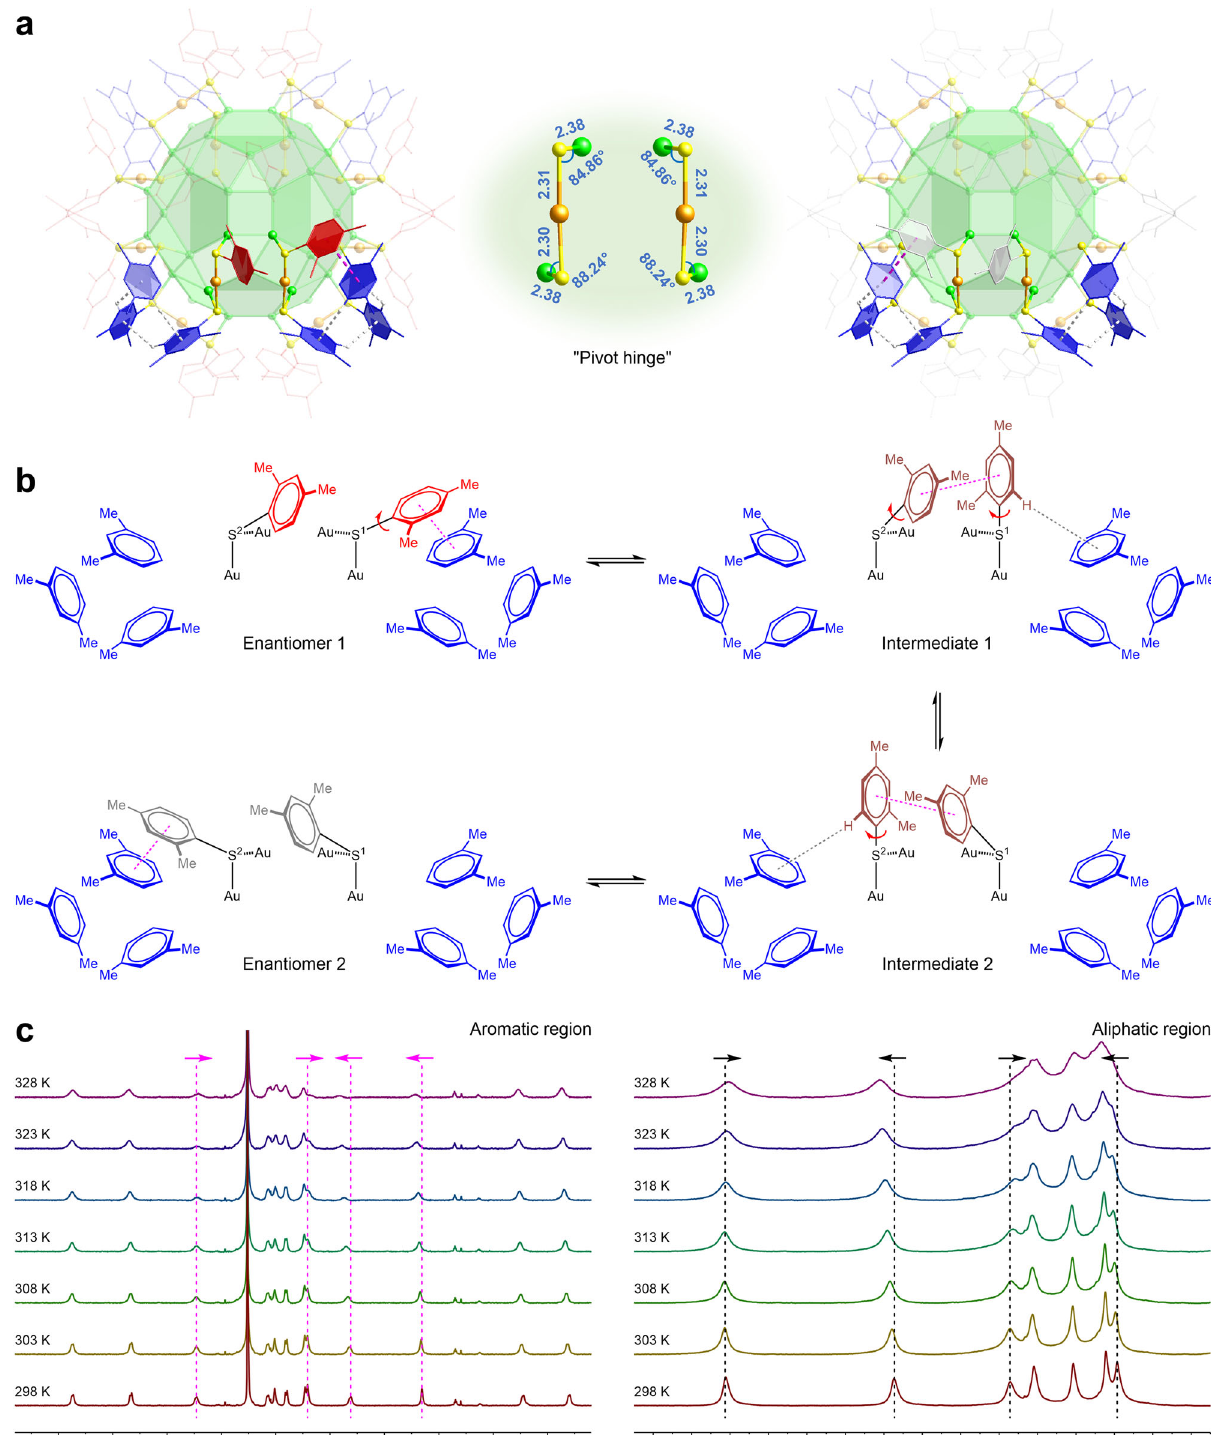
Fig. 3 | An interconversion mechanism for structural analysis of Au 138 (SR) 48 . a Highly symmetrical [Au – S – Au – S – Au] 2 moiety supporting the dynamic behaviors of aromatic rings. Color labels: Au, green and orange; S, yellow; C, red, blue, and gray; H, white. b A schematic representation of the interconversion process